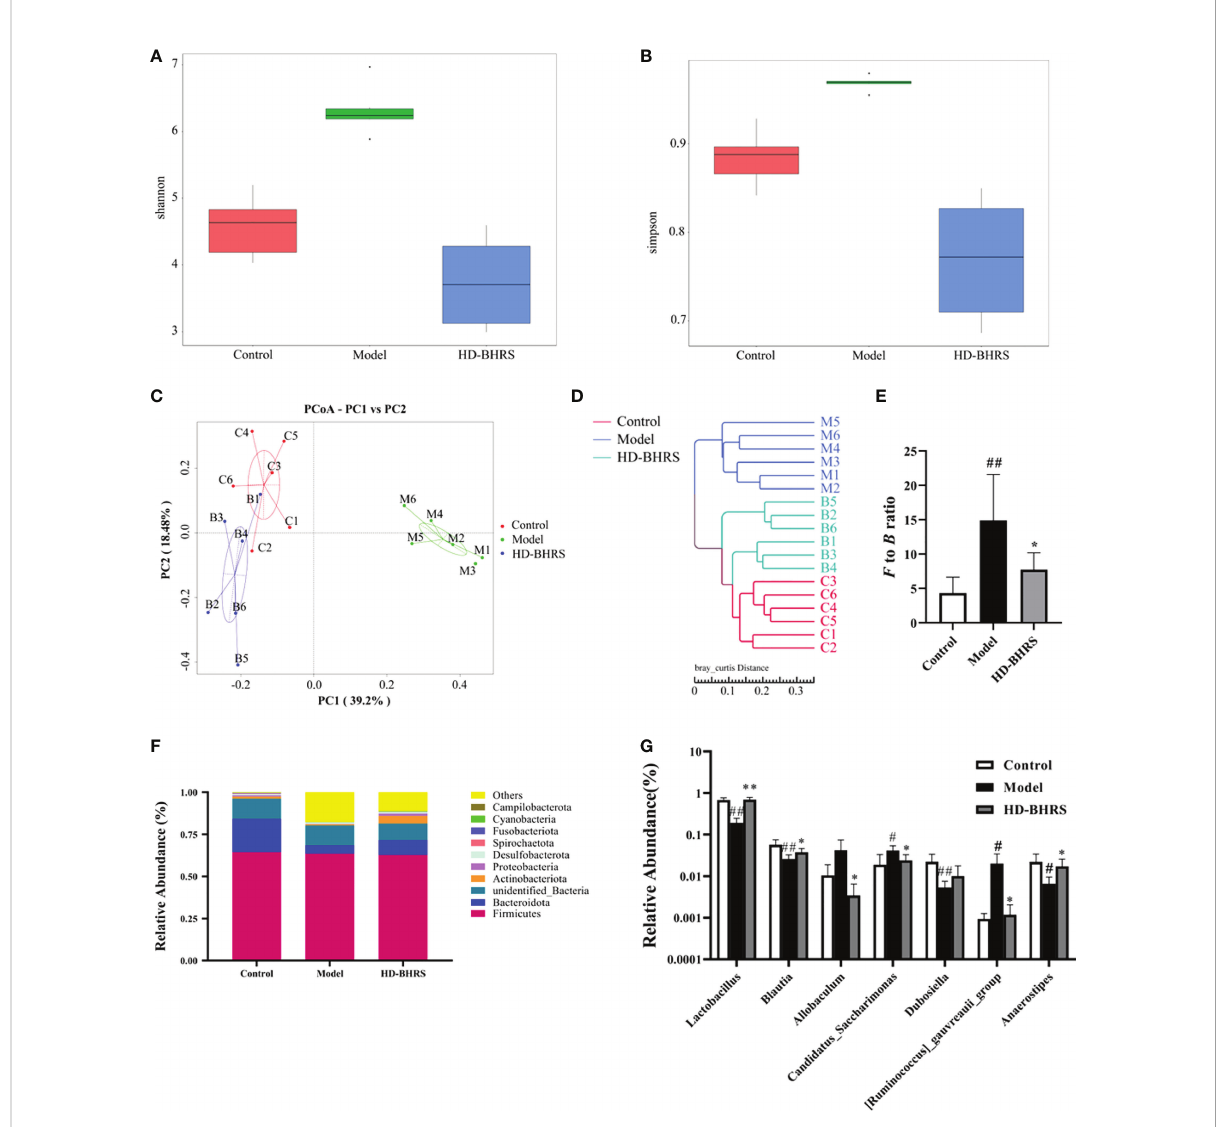
FIGURE 5 BHRS treatment affected the gut microbiota community in T2DM model rats. (A, B) Shannon and Simpson index was lower in HD-BHRS group than that in the T2DM group. (C, D) PCoA and system clustering tree indicated more similar beta diversity between HD-BHRS and control groups than that between the T2DM and control groups (C: Control group; T: T2DM group; B: HD-BHRS group). (E, F) At the phylum level, BHRS treatment decreased the F to B ratio in T2DM model rats. (G) At the genus level, BHRS treatment affected the relative abundances